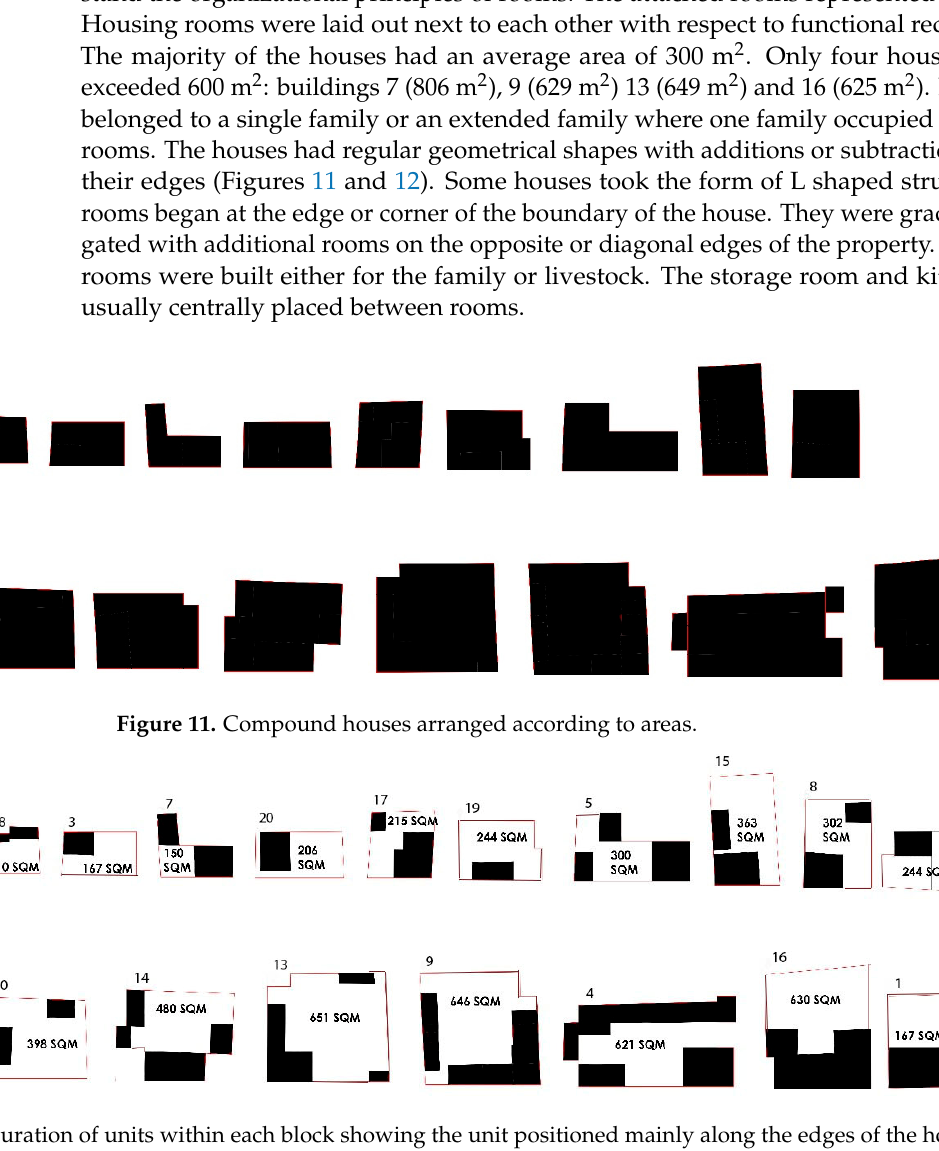
Figure 12. Configuration of units within each block showing the unit positioned mainly along the edges of the house.